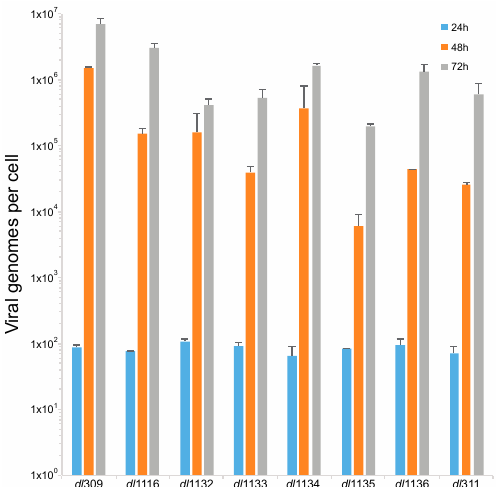
Figure 6. Deletions within the C-terminus of E1A affect viral genome replication. Arrested WI-38 cells were infected with the indicated mutant viruses at a MOI of 100. At the indicated time points, viral DNA was extracted and quantified by qPCR using the E1B primers and pXC1 plasmid to generate the standard curve. Viral genomes are plotted on per cell basis. All differences at 48 and 72 h were statistically significant versus dl 309 with a p value ≤ 0.0002, except for the 24 h time point where there was no statistically significant difference between dl 309 and the mutant viruses. Error bars represent standard deviation of biological replicates, n = 3.